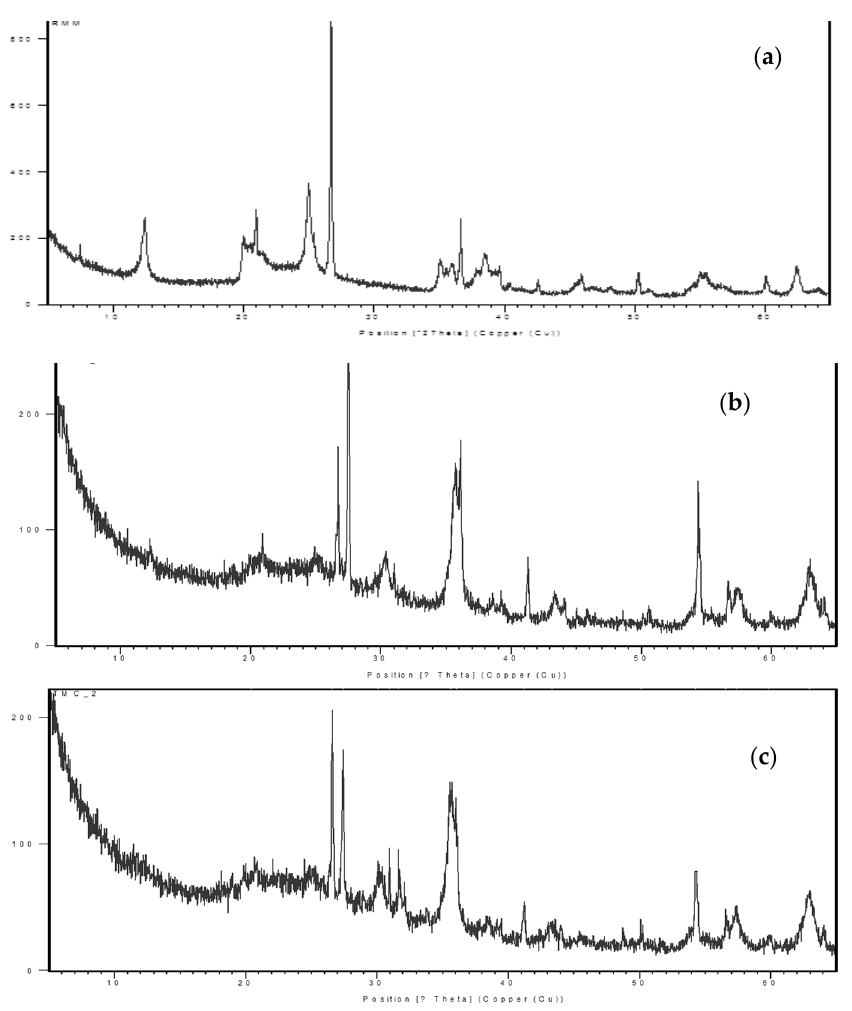
Figure 5. ( a – c ): XRD patterns of ( a ) unmodified montmorillonite, ( b ) doped titanium composite and ( c ) tripartite magnetic montmorillonite composite.